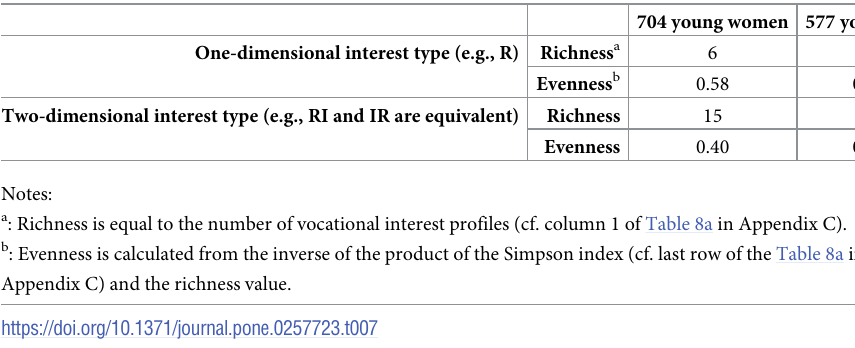
Table 7. Richness and evenness of vocational interests according to gender.